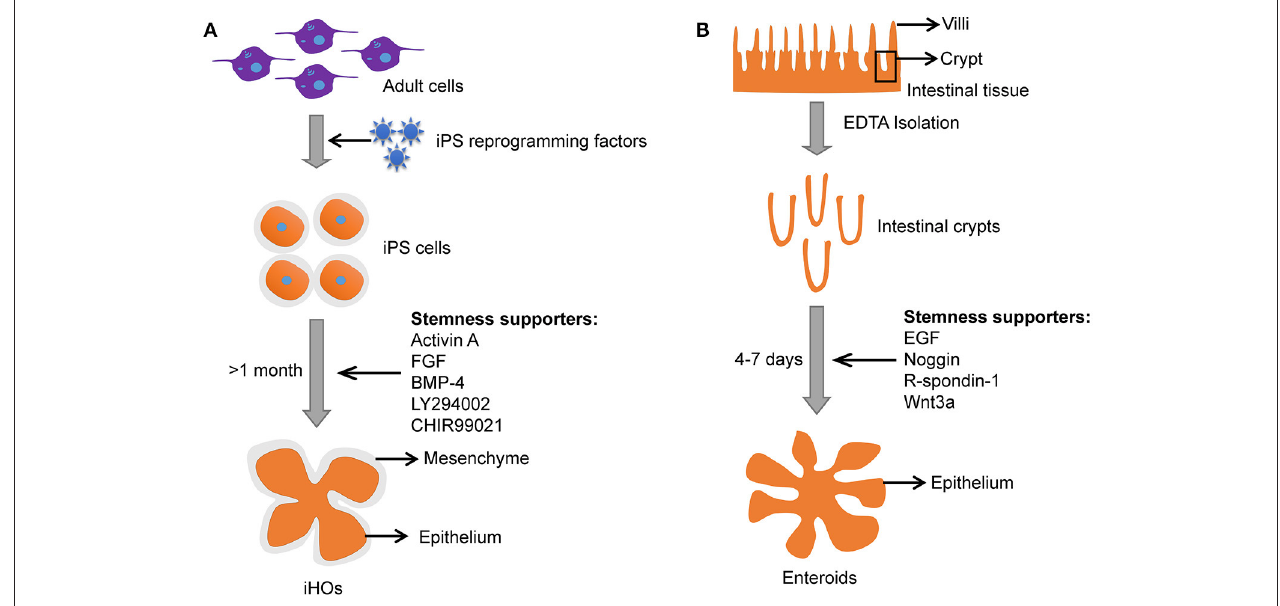
FIGURE 3 | Comparison between iHOs and primary enteroids. (A) Culture process and features of iHOs. (B) Culture process and features of primary